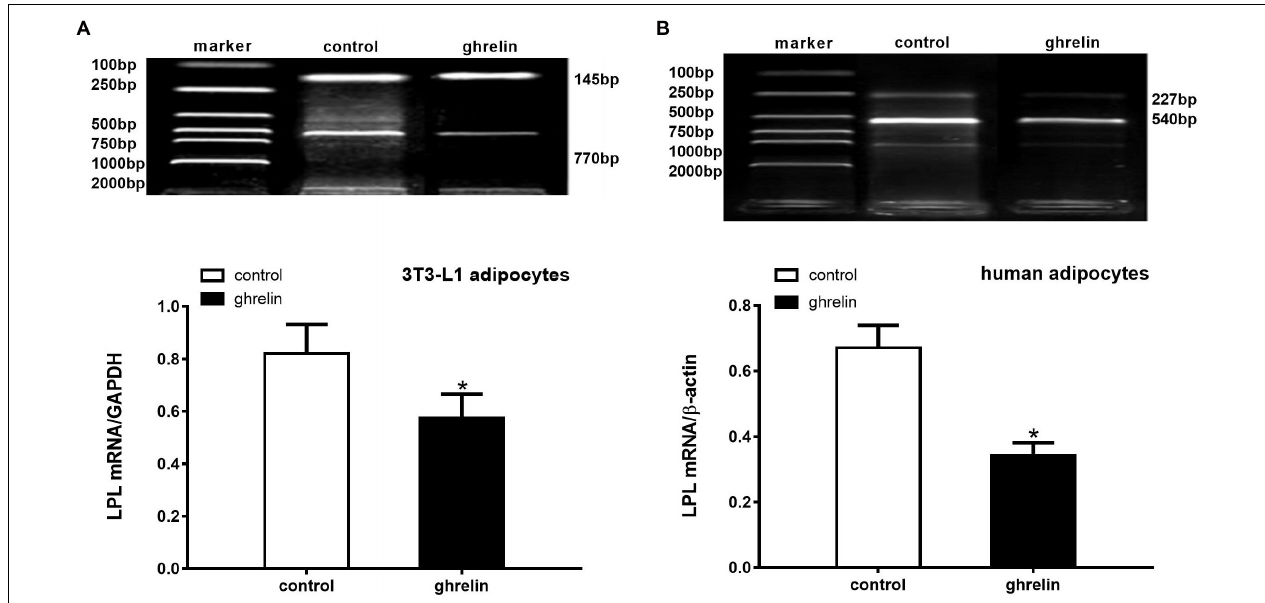
FIGURE 6 | Ghrelin inhibited the LPL mRNA levels in 3T3-L1 and human differentiating adipocytes. Levels of LPL mRNA in 3T3-L1 (A) and human adipocytes (B) were measured by RT-PCR after treatment with 10 ng/ml ghrelin. LPL (770 bp) and GAPDH (145 bp) in 3T3-L1 preadipocytes, as well as LPL (227 bp) and β -actin (540 bp) in human adipocytes are shown with molecular markers in the upper panel of (A,B) . In the lower panel, data were calculated using the density ratio of LPL to GAPDH (A) and β -actin PCR products (B) . The data are presented as the mean ± SD for three independent experiments. ∗ p < 0.05 vs. control group.